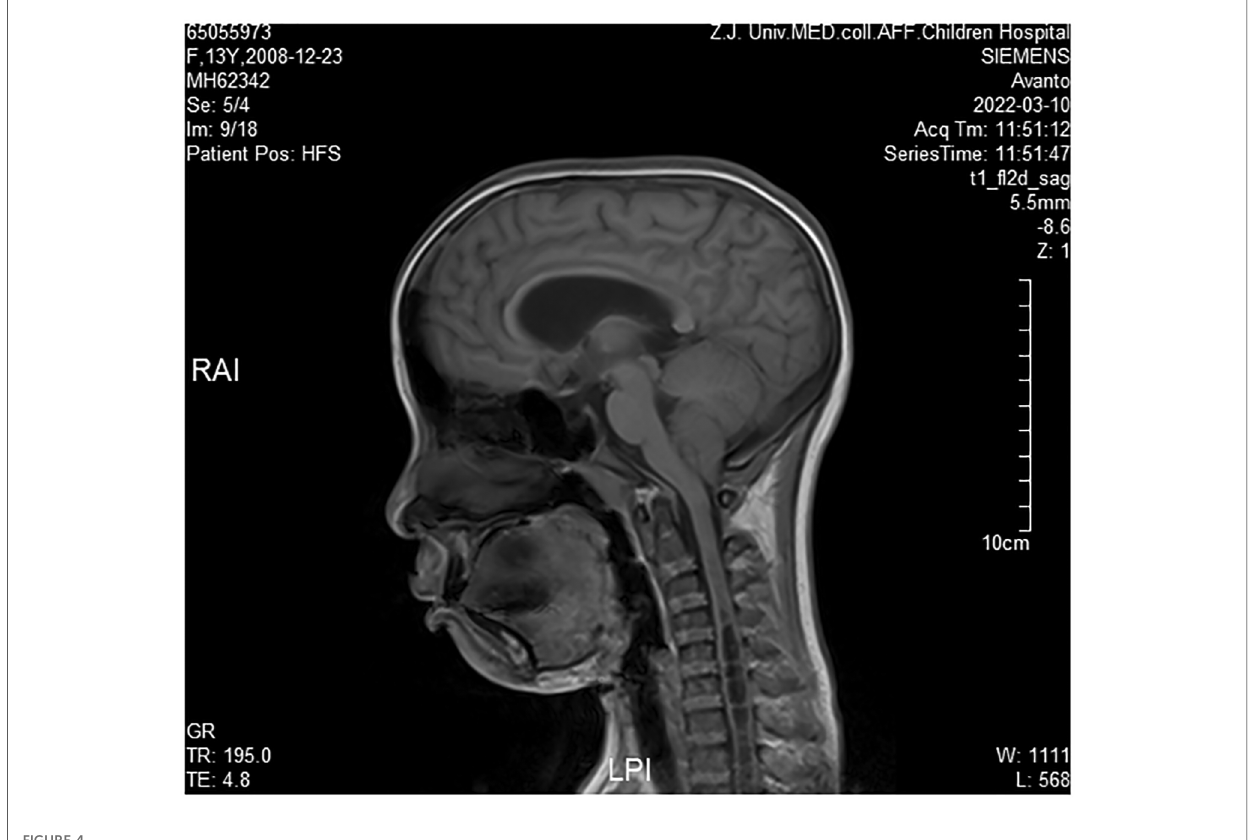
FIGURE 4 Brain MRI (transverse